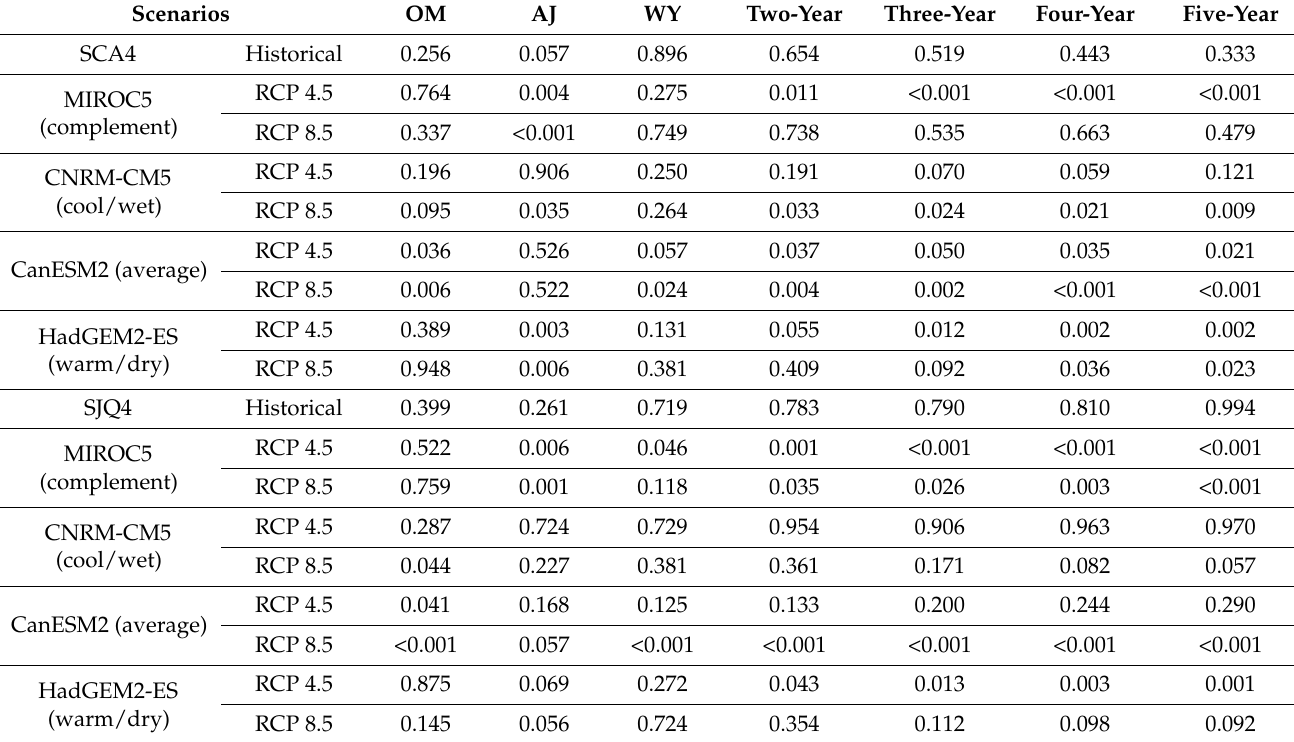
Table A3. p -values of trends in SSI indices presented in Table